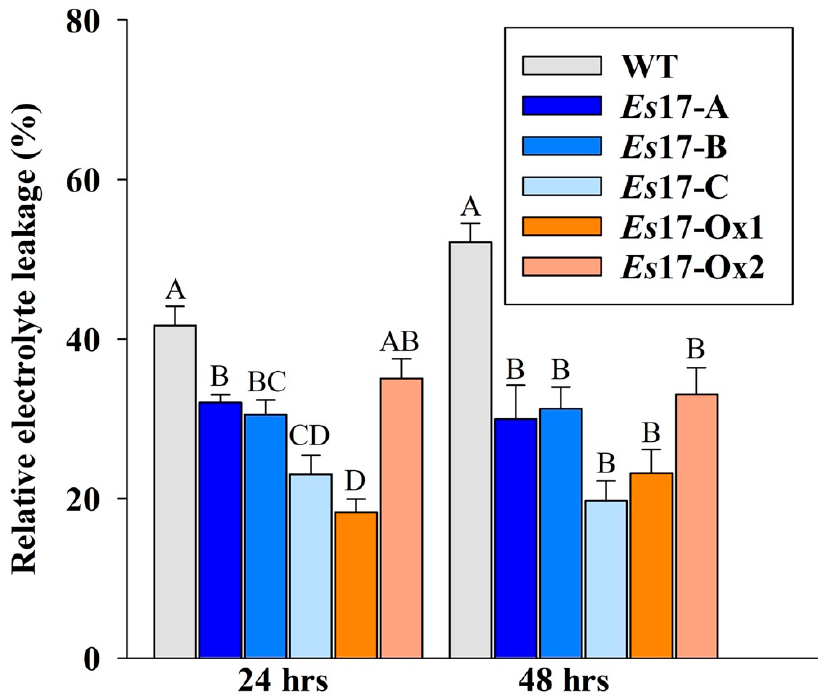
Figure 5. Electrolyte leakage of wild type and 2 independent 35S promoter ( Es 17Ox-1-2,) and of 3 independent stress inducible promoter ( Es 17A-C) transgenic A. thaliana plants, under 100 mM salinity stress conditions. Values represent mean and standard error ( n = 15). Means and SE followed by the same letter are not significantly different.